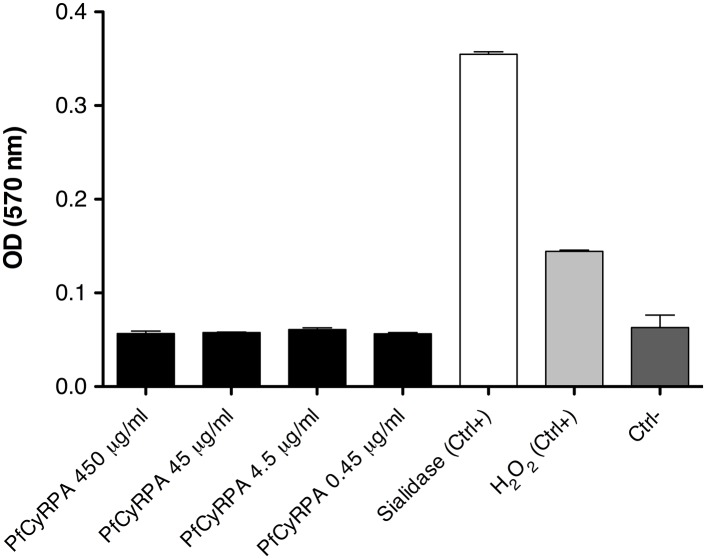
PfCyRPA lacks detectable sialidase activity in a functional assay.Sialidase activity was estimated using the Amplex Red Neuraminidase (Sialidase) assay kit (Molecular Probes, Inc.). The assay utilizes Amplex Red to detect H2O2 generated by galactose oxidase oxidation of desialiated galactose, the end product of sialidase activity. The H2O2 in the presence of HRP reacts with Amplex Red reagent to generate resorufin, the red fluorescent oxidation product, which was detected at 570 nm using the Sunrise Absorbance Reader (Tecan). PfCyRPA was mixed 1:1 (v/v) with the Amplex Red reagent/HRP/galactose oxidase/fetuin working solution (0.2 U/mL HRP, 4 U/mL galactose oxidase, 500 µg/mL fetuin), and the mixture was incubated at 37°C for 30 min in a light-protected container. Sialidase and H2O2 (supplied with the kit) were used as positive controls (Ctrl+); a no-sialidase sample as negative control (Ctrl−).